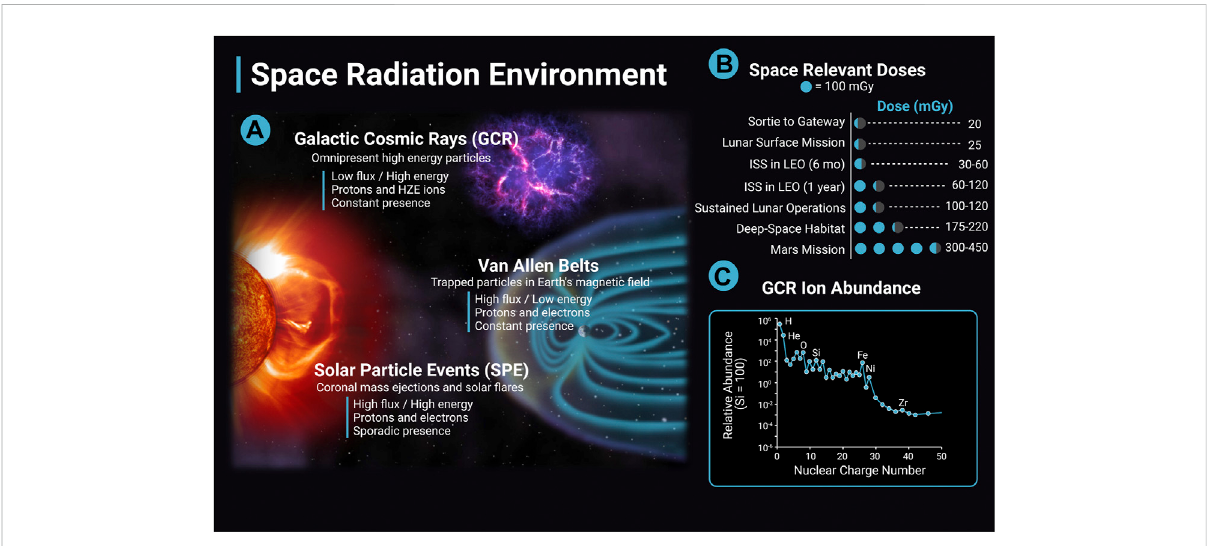
FIGURE 2 The space radiation environment. The space radiation environment consists of three main sources of radiation, solar particle events (SPE), Van Allen belts, and galactic cosmic rays (GCR). (A) GCR are high energy nuclei that originate from outside the solar system, possibly from supernovas, and are omnipresent. GCR have a low fl ux and high energy and consist largely of protons and high (H) atomic number (Z) and energy (E) (HZE) ions. The activity of GCR is anticorrelated with solar activity. SPEs are solar storms including solar fl ares and coronal mass ejections. They have high fl ux and high energy, consist mainly of protons and electrons, and the frequency of SPEs are cyclic depending on solar activity. A single SPE can last from hours to days. Van Allen Belts are trapped particles within Earth ’ s magnetic fi eld that have high fl ux and low energy. Particles can be captured from solar events and GCR interactions with the Earth ’ s atmosphere. The inner belt is largely protons, and the outer belt is primarily electrons. (B) Space-relevant radiation doses in mGy for different missions are adapted from Simonsen et al. (2020). Dose estimates are during solar